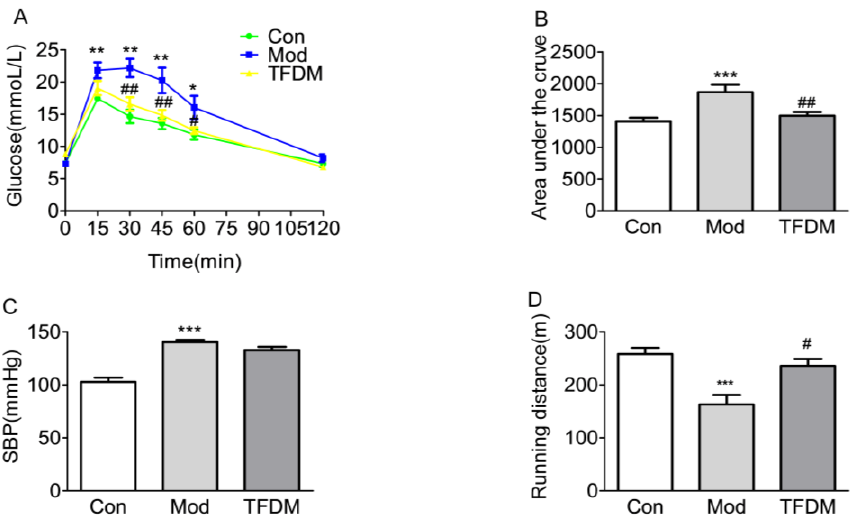
Figure 7. Effects of TFDM on blood glucose, blood pressure, and running distance. ( A ) Intraperitoneal glucose tolerance test (ipGTT) after treatment. ( B ) Bar graphs depicting the area under the curve of 10-week time points in the ipGTT experiment. ( C ) Systolic blood pressure (SBP) of different experimental groups. ( D ) Running distance of different experimental groups ( n = 6). Compared with Con group: * p < 0.05, ** p < 0.01, *** p < 0.001; compared with Mod group: # p < 0.05, ## p < 0.01.